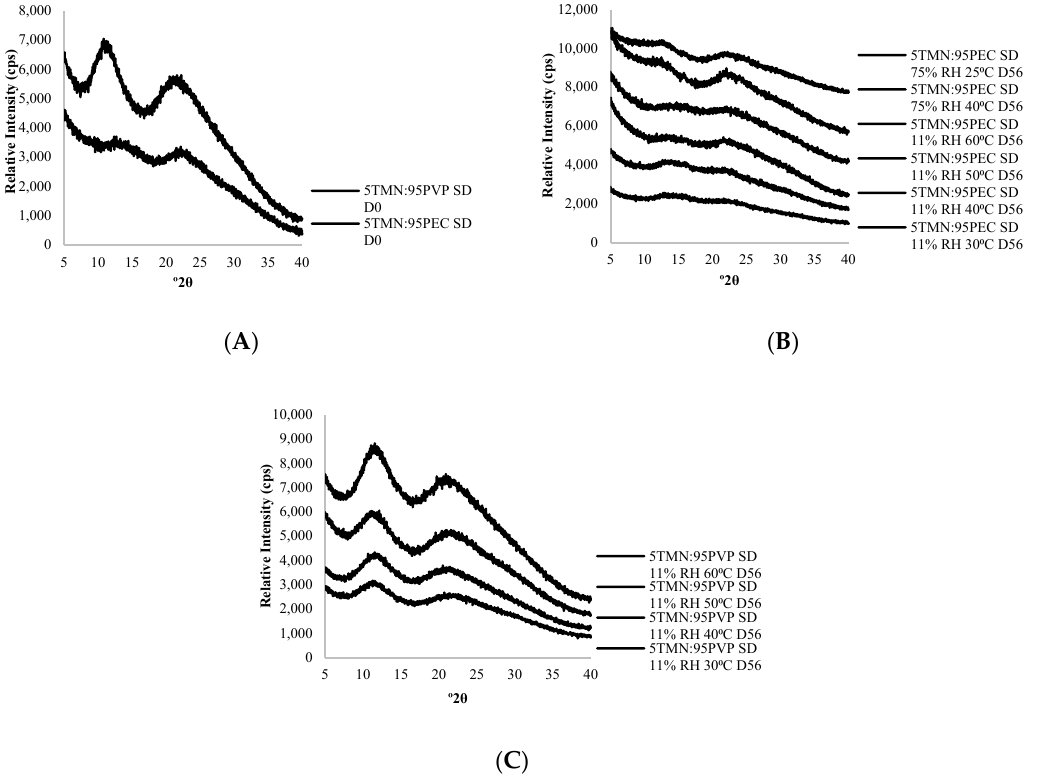
Figure 2. X-ray powder di ff raction patterns of: ( A ) 5TMN:95PEC and 5TMN:95PVP solid dispersions (SD) immediately following lyophilization; ( B ) 5TMN:95PEC solid dispersions (SD) stored at 11% relative humidity (RH), 30–60 ◦ C and 75% RH, 25 or 40 ◦ C on day 56; and ( C ) 5TMN:95PVP solid dispersions (SD) stored at 11% RH and 30–60 ◦ C on day 56. No evidence of TMN crystallization was found in PXRD patterns of TMN:polymer dispersions that were initially amorphous (TMN:PVP containing ≤ 10% TMN and TMN:PEC containing ≤ 20% TMN) in samples stored at 11% RH over the 8 week storage study, regardless of storage temperature. PXRD patterns of amorphous 5TMN:95polymer dispersions before and after storage are shown in